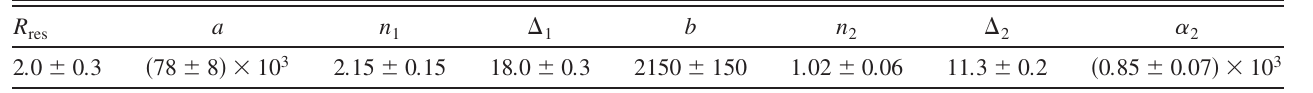
TABLE XI. Fit parameters for Eq.